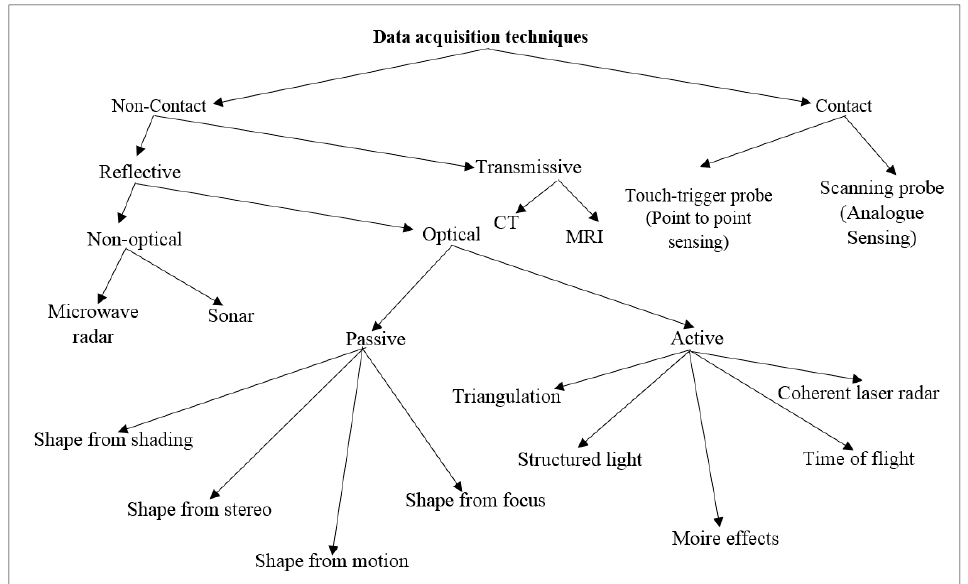
Figure 1. Classification of data acquisition techniques [3,5,6]. CT: computed tomography; MRI: magnetic resonance imaging.